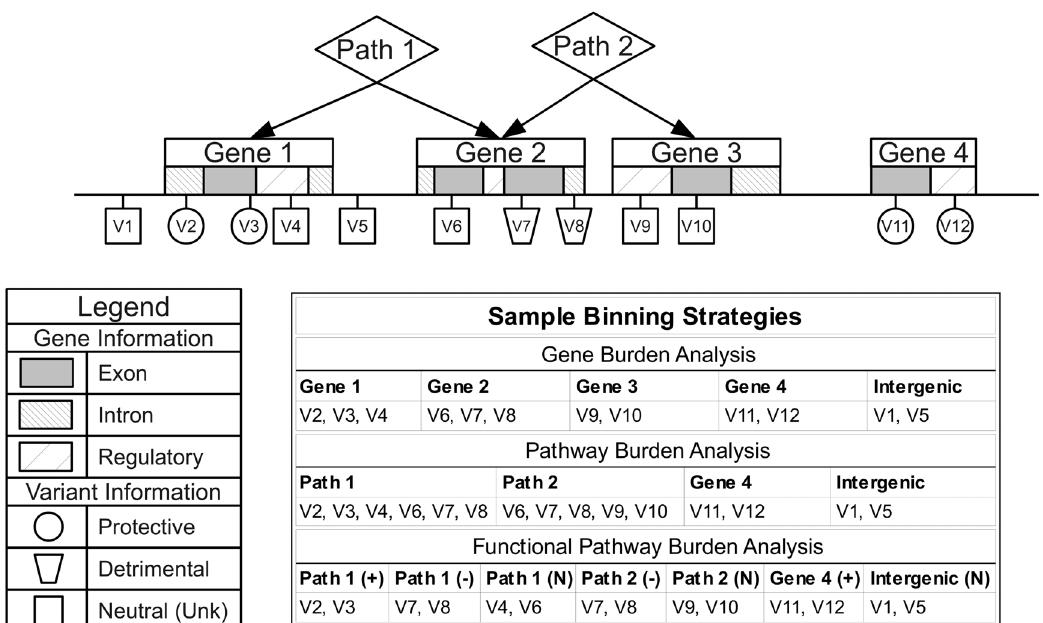
Figure 8. Alternate binning strategies using biological knowledge and functional or role annotations. Three example binning strategies: gene burden analysis, pathway burden analysis, and functional pathway burden analysis using four genes, two pathways, and variant functional prediction information.